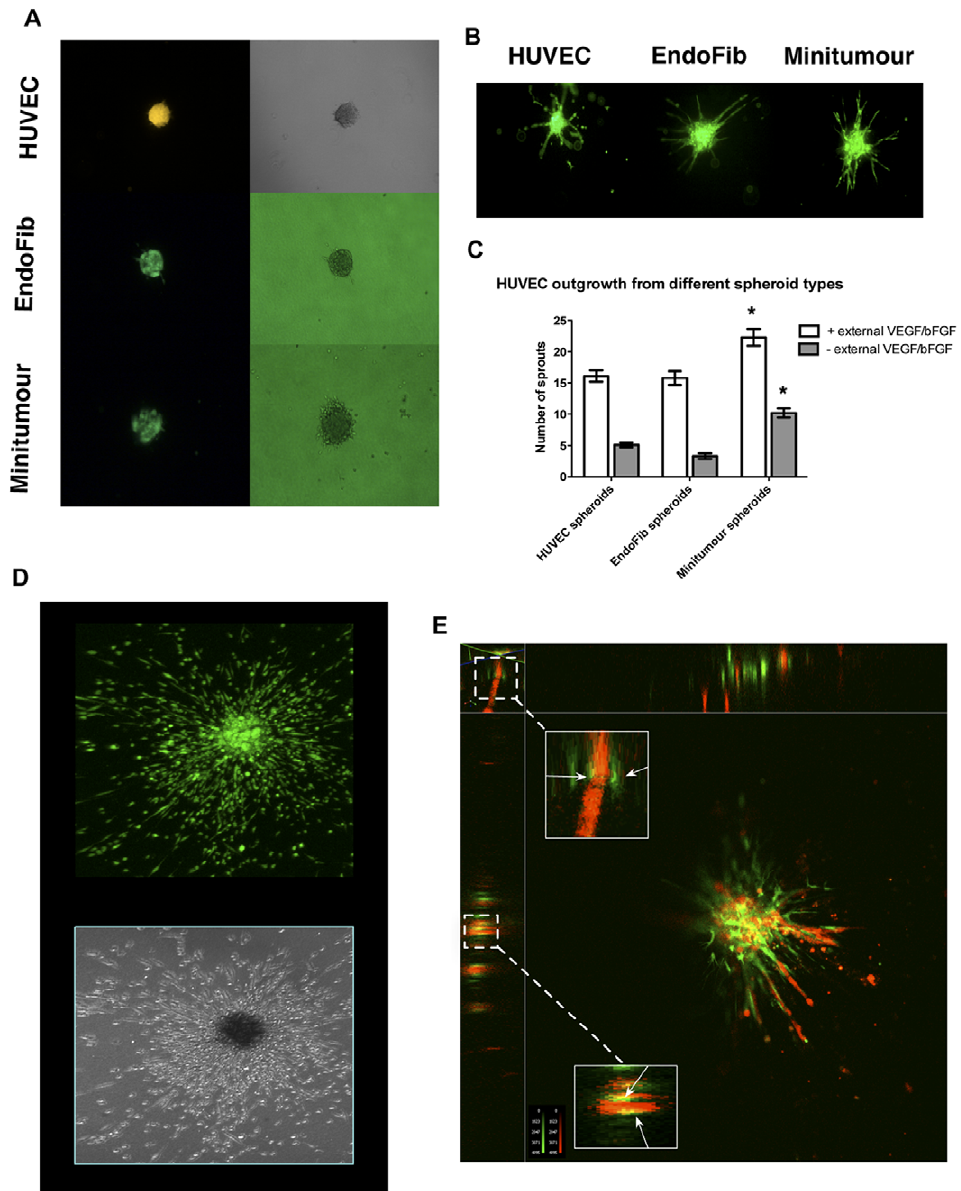
Figure 1. Characterization of the Minitumour spheroid model. A - Fluorescent (left) and phase contrast (right) images of HUVEC, EndoFib and Minitumour spheroids before incubation in the collagen gel; endothelial cells pre-dyed with a CMFDA Green CellTracker dye are seen in each different spheroid type. B – Representative fluorescent images of spheroids after 48 h incubation in collagen gels, in the presence of complete medium, showing pre-dyed endothelial cells organized into pre-capillary sprouts. C – Quantification of endothelial sprout length from different spheroids show that MDA-MB-231 cells stimulate sprout formation even in the absence of exogenous growth factors VEGF and bFGF. D – Confocal (upper) and phase contrast (lower) images of MDA-MB231 cells pre-dyed with the green CellTracker dye in the Minitumour spheroid after 48 h incubation in complete medium. E - A 3D reconstruction of a Minitumour spheroid where the HUVECs have been dyed with a CMRA Orange CellTracker dye and the fibroblasts with a CMFDA Green Cell Tracker side panels show optical x and y sections of sprouts showing the deposition of HUVECs and Fibroblasts relative to sprout formation.